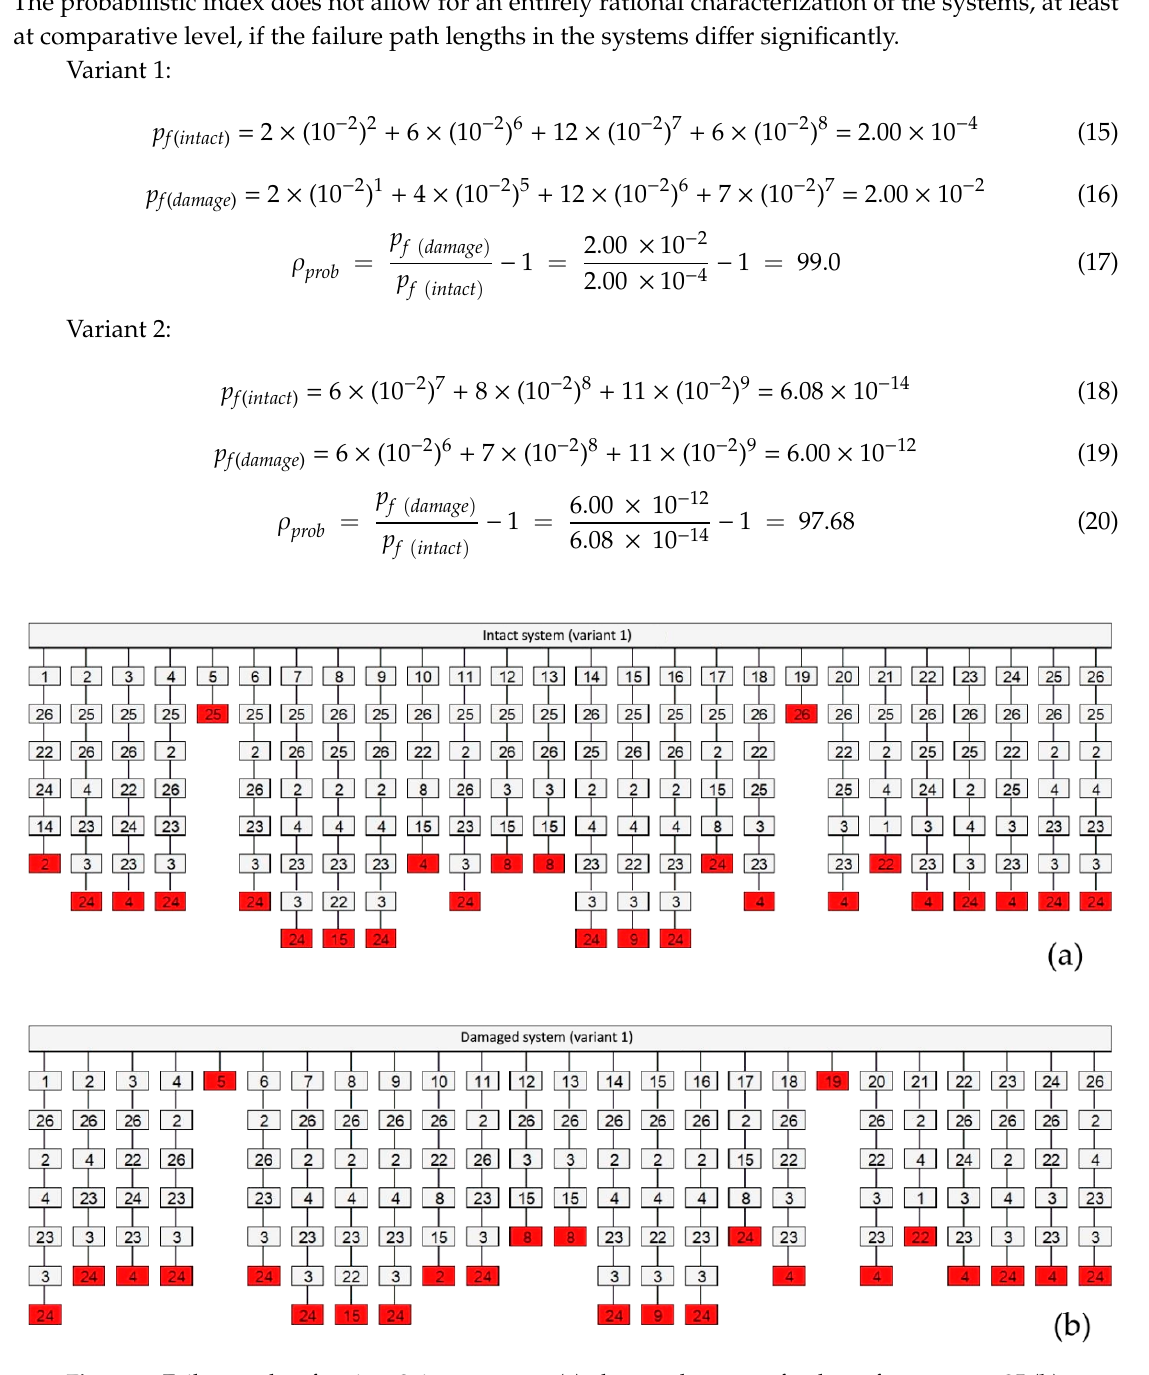
Figure 8. Failure paths of variant 2; intact system ( a ); damaged system after loss of component 25 ( b ).